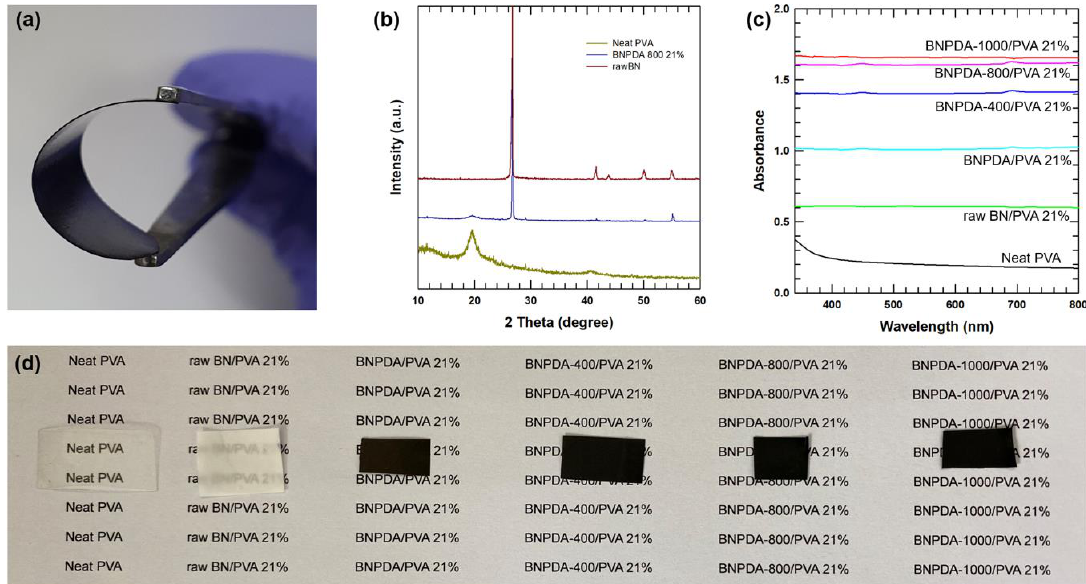
Figure 5. ( a ) Digital photograph of flexible BNPDA-800 / PVA composite film. ( b ) XRD pattern of raw BN, BNPDA-800 / PVA, and neat PVA. ( c ) UV–Vis absorbance spectra of composite films and ( d ) their optical images.